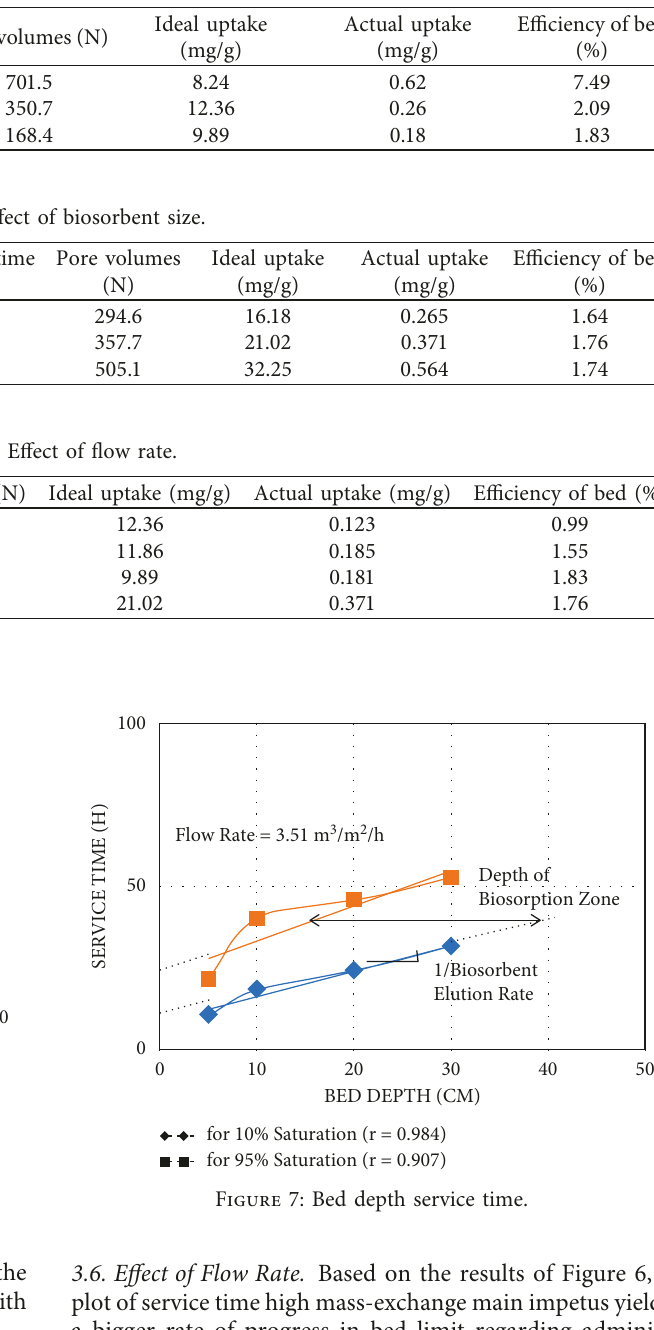
Table 1: Effect of initial sorbate concentration.